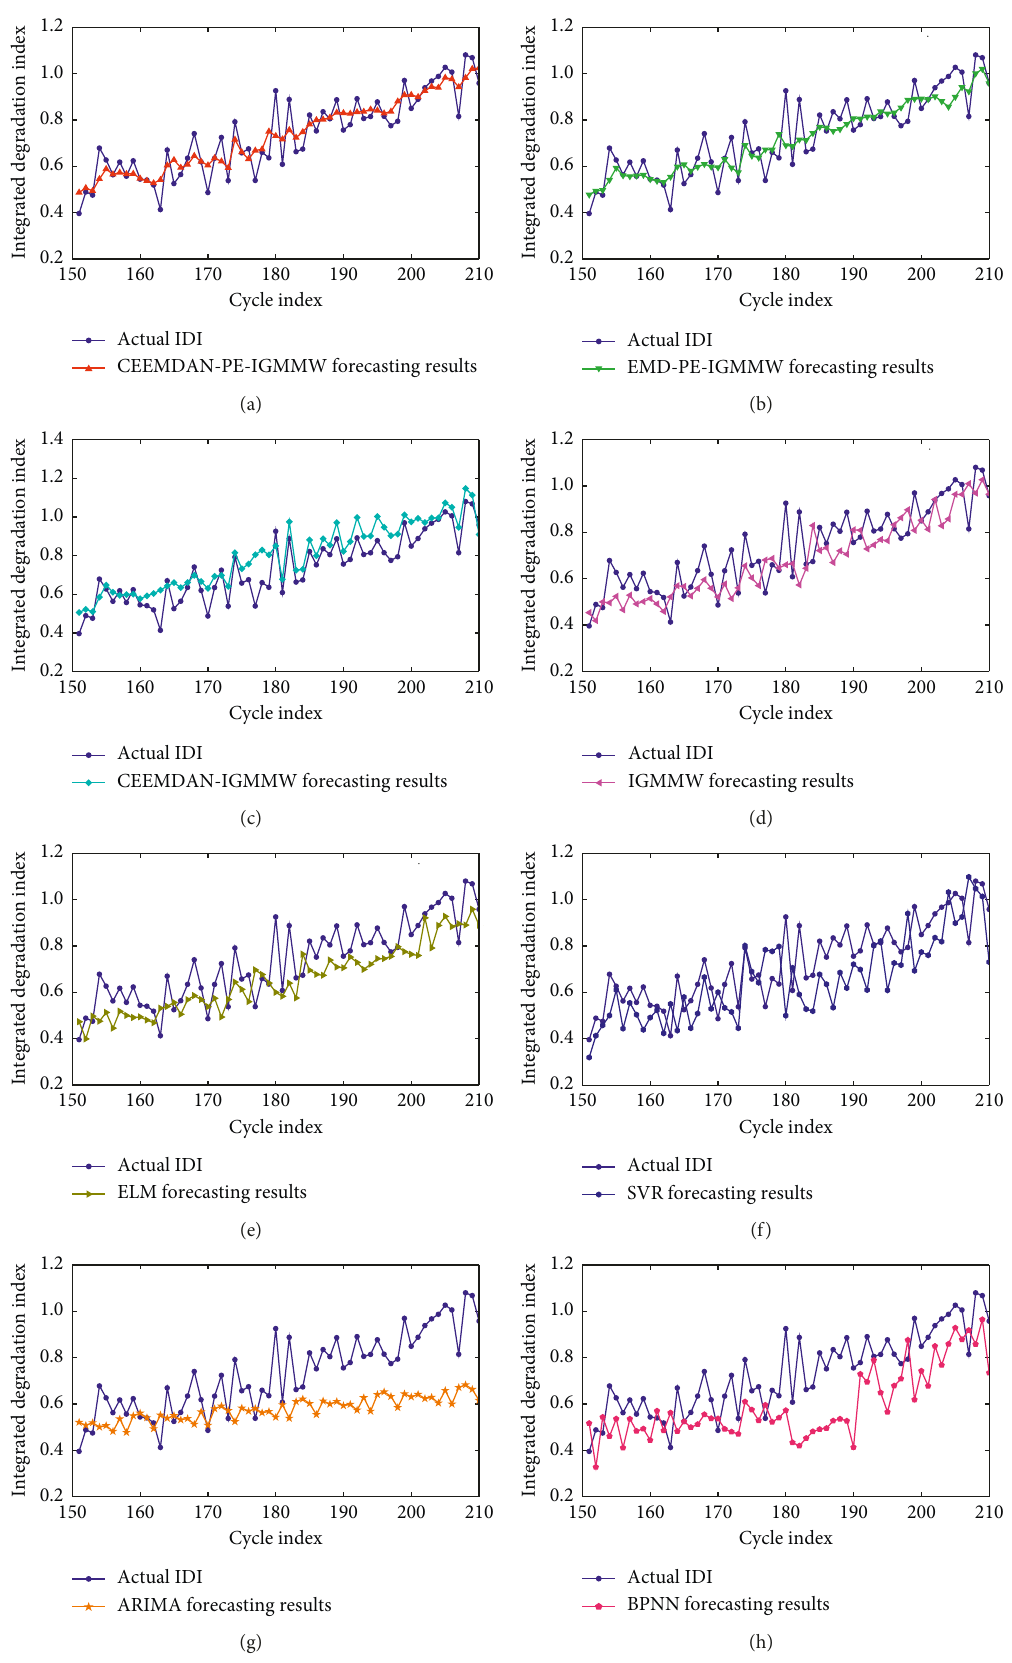
Figure 14: Comparisons of the forecasting results of eight models in the degradation tendency